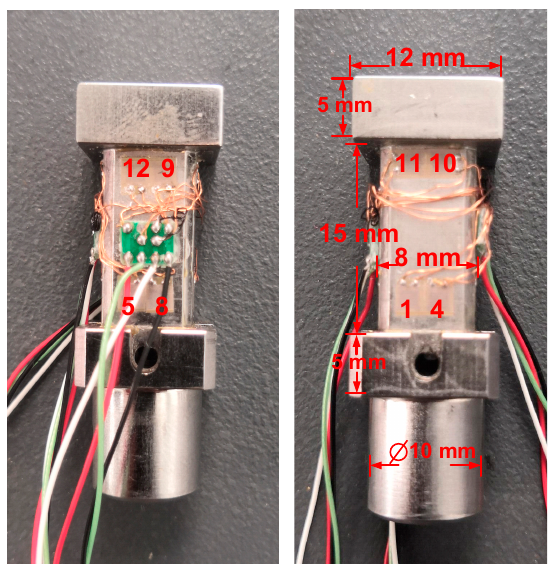
Figure 5. Physical dimensions of strain sensor.